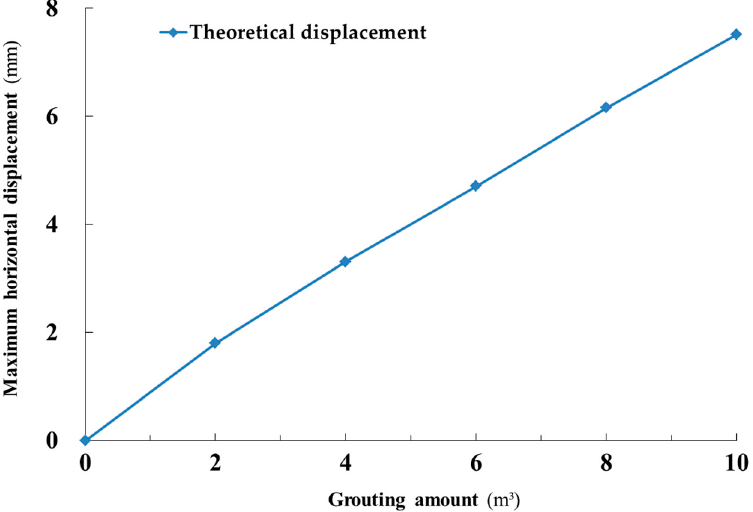
Figure 10. The relationship between the volume of grouting and the maximum horizontal dis- placement of the tunnel.